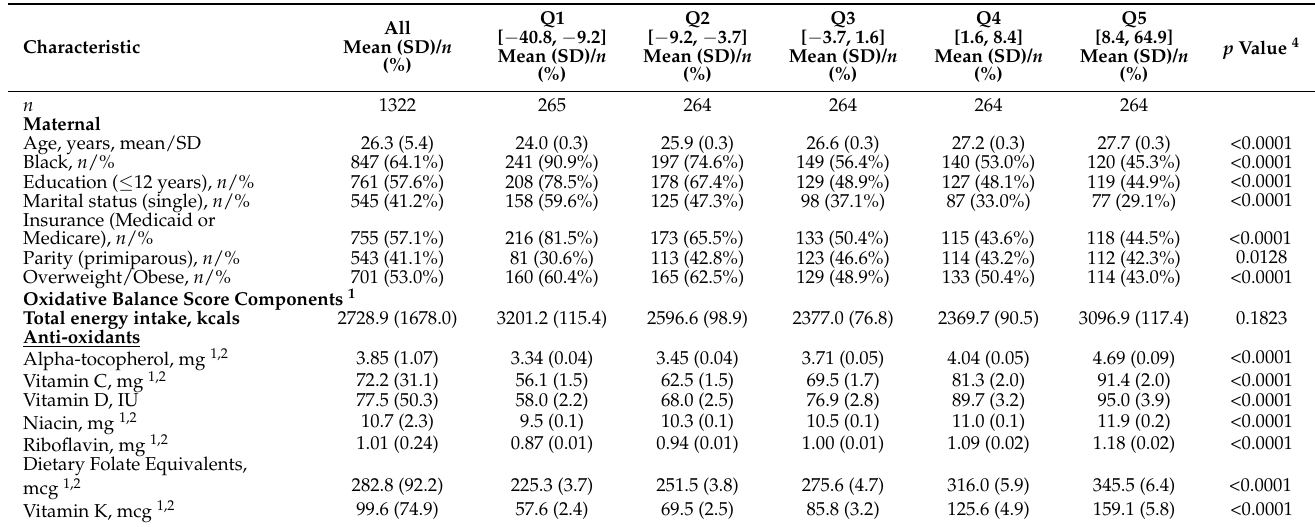
Table 1. Characteristics according to Oxidative Balance Score, by Quintiles presented as mean (SD) or n